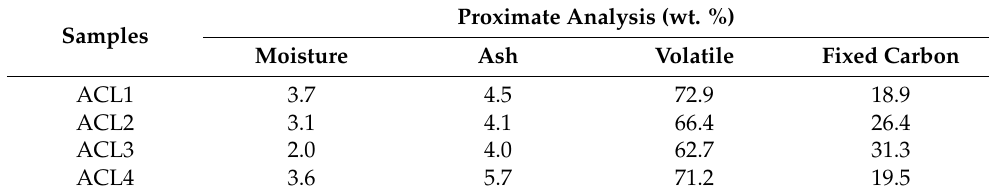
Table 2. Proximate Analysis of